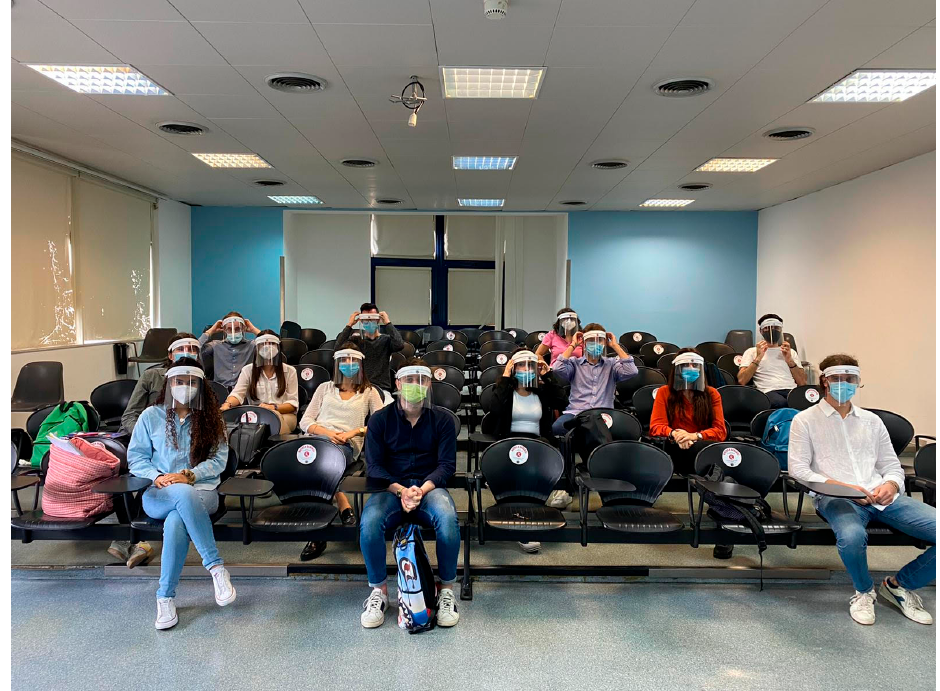
Figure 1. Classroom with protective visors.